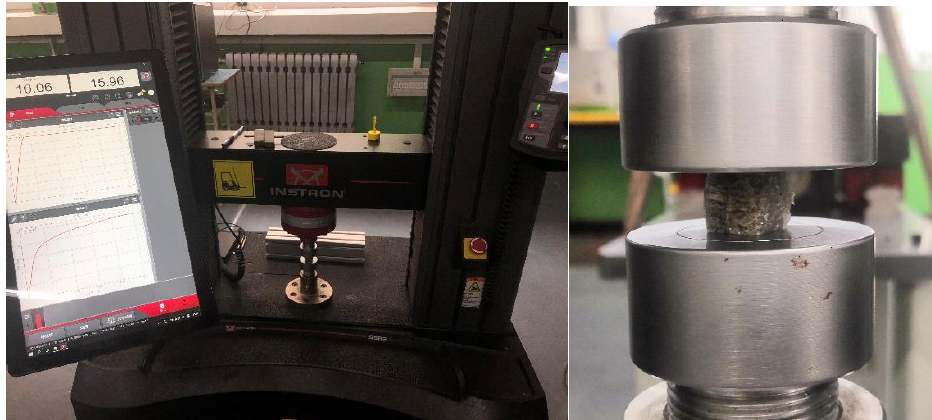
Figure 4. Experimental equipment and close-up of the